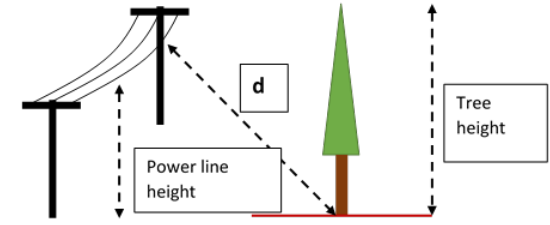
Figure. 2. Proximity pixel modelling using LIDAR-based